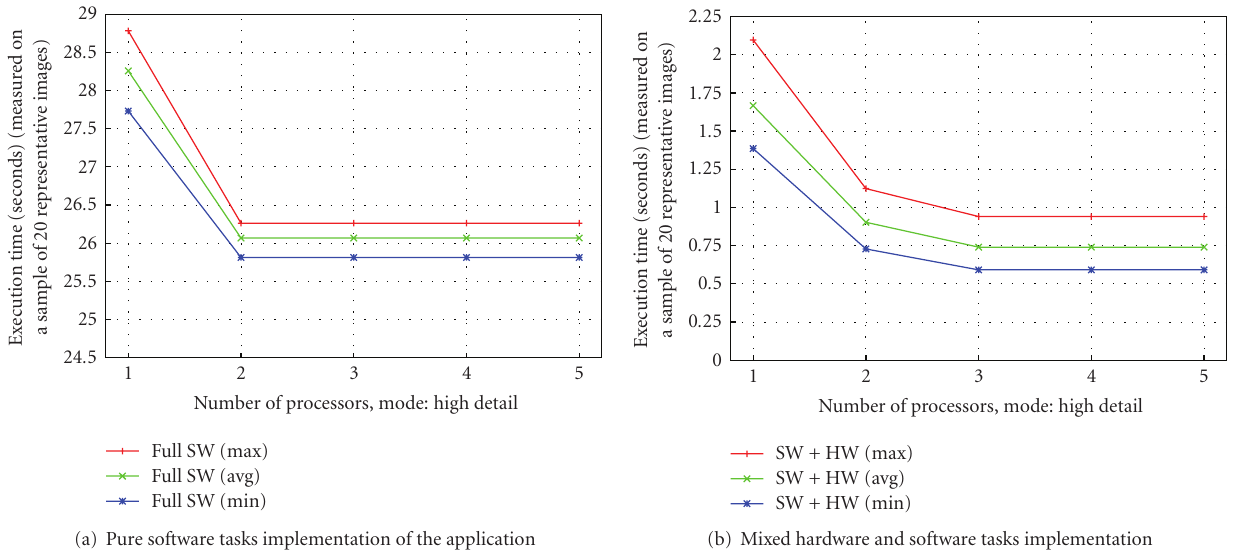
(b) Mixed hardware and software tasks implementation Figure 15: Performance gain exploration for several sizes of MPRSOC architectures for case (a) all tasks in software; case (b) partitioned in hardware (on a DRA) and software on multiple processors.